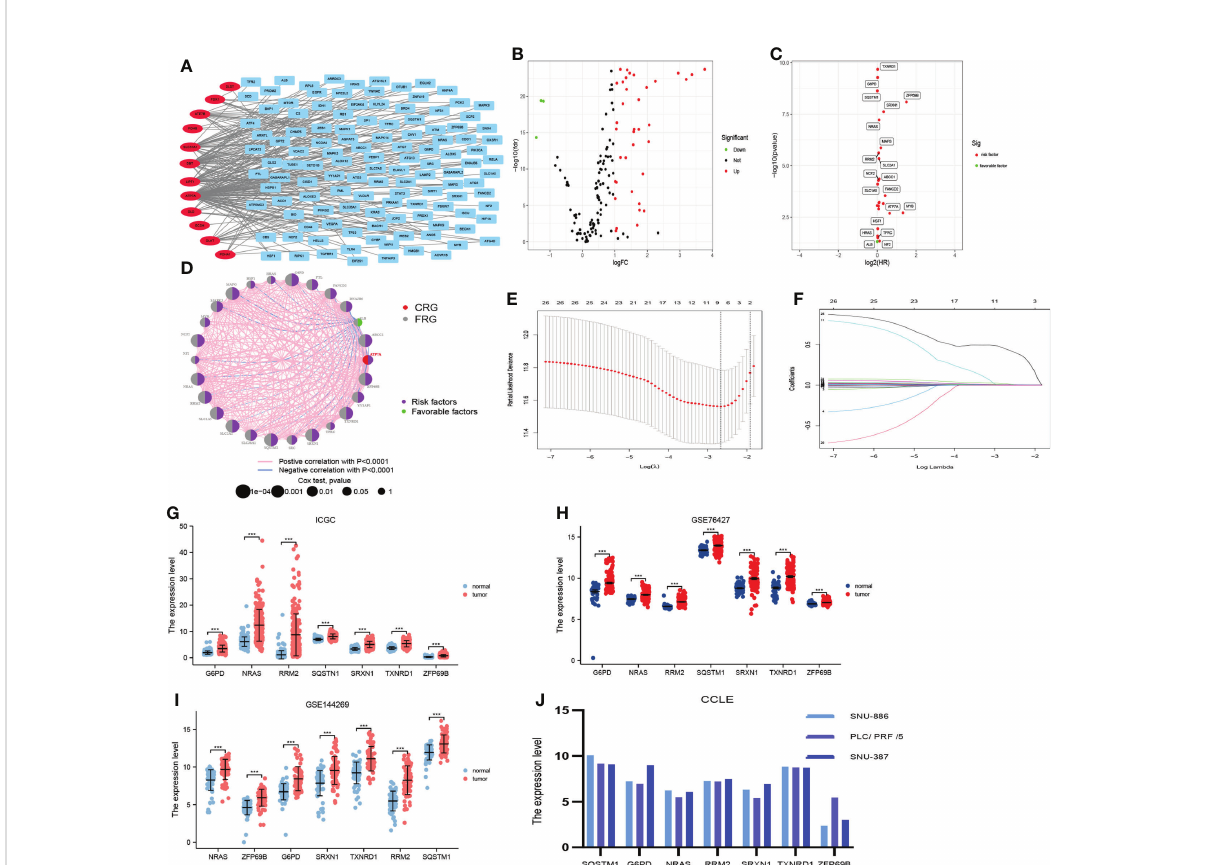
FIGURE 2 Construction of the prognostic signature (CRFs) in TCGA. (A) The correlation between cuproptosis-related genes and ferroptosis-related genes. (B) Differential expression of cuproptosis-related genes and cuproptosis – ferroptosis-related genes in hepatocellular carcinoma (HCC) versus normal tissues. (C) Univariate regression analysis of differentially expressed genes (DEGs). (D) The network of candidate genes. (E) Least absolute shrinkage and selection operator (LASSO) coef fi cient pro fi les. (F) Candidate genes were fi ltered by the LASSO algorithm. (G) Veri fi cation of the expression of genes constituting CRFs on patients with HCC in ICGC. (H) Veri fi cation of the expression of genes constituting CRFs on patients with HCC in GSE76427. (I) Veri fi cation of the expression of genes constituting CRFs on patients with HCC in GSE144269. (J) Veri fi cation of the expression of genes constituting CRFs on patients with HCC in